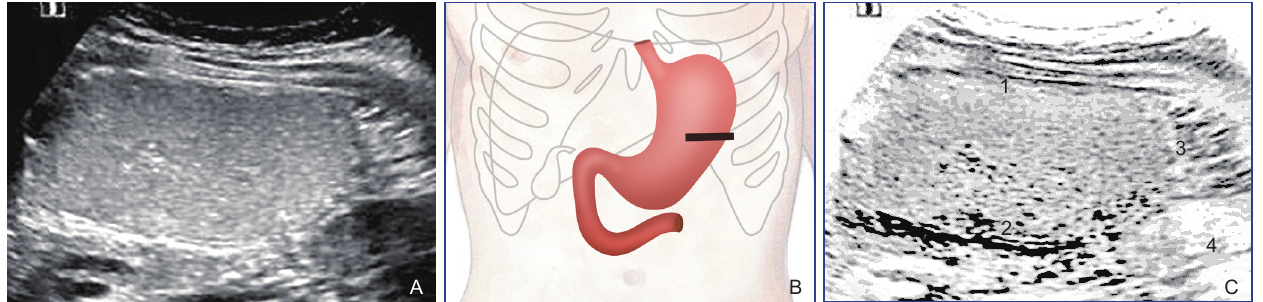
Figure 8 Short-axis section of the middle and lower gastric body and schematic diagram of the section (scan under the left side of xiphoid process). A, Ultrasound image; B, Schematic diagram of scanning; C, Schematic diagram of ultrasonogram (1, Anterior wall of the stomach; 2, The posterior wall of the stomach; 3, Greater curvature; 4, Left kidney)